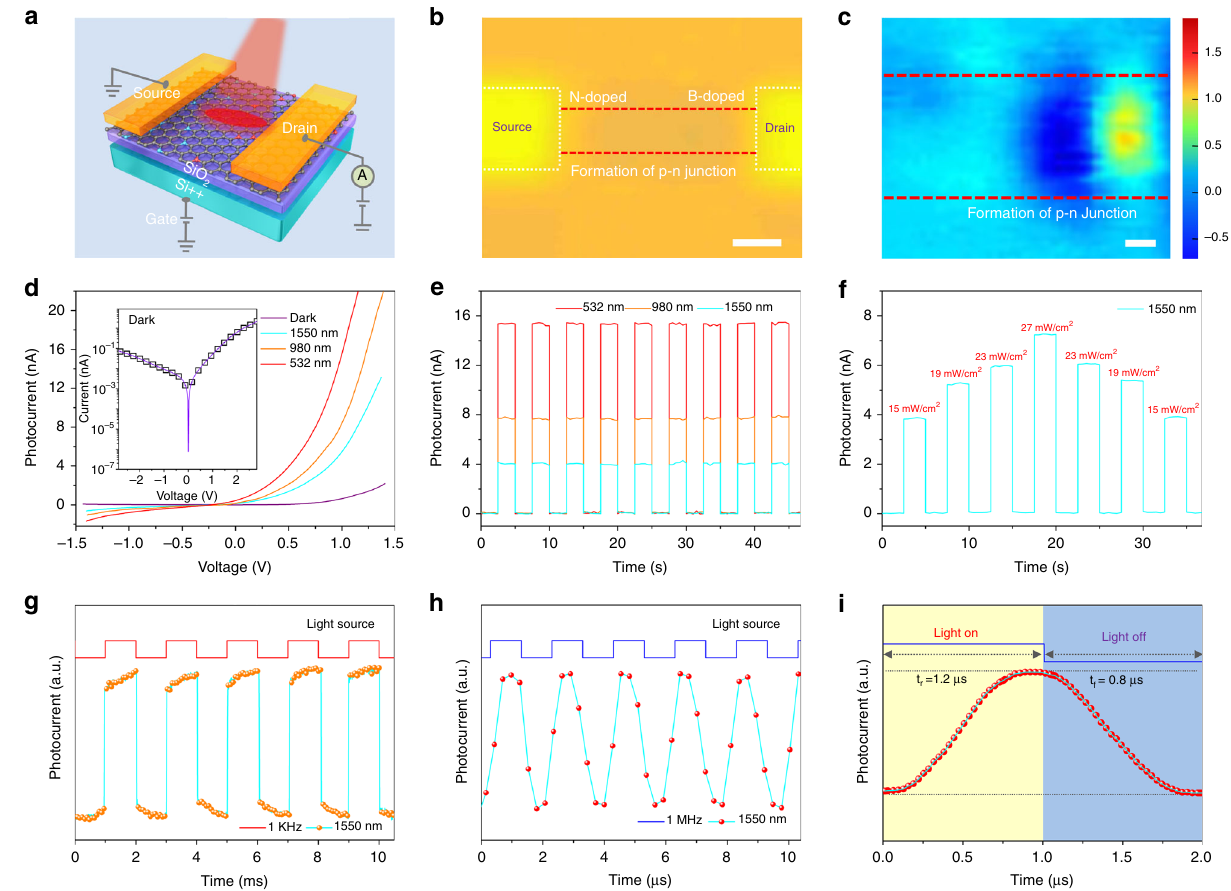
Fig. 4 Photoelectric properties of the seamless lateral graphene p – n junction. a Schematic illustration of the photodetector. b Optical micrograph of the scanned area for the photocurrent mapping measurement with the dotted lines showing the contour of the photodetector. The scale bar is 2 μ m. c Photocurrent mapping across the entire B-doped/N-doped seamless connected area (the fl uences of 4 × 10 16 atoms/cm 2 are used for both N-doped and B-doped portions) at the biasing condition of V ds = V g = 0 V. The photoexcitation power is 500 μ W and the wavelength is 633 nm. The laser spot size is 1 μ m with the spatial resolution of 0.5 μ m. The scale bar is 500 nm. d I − V ds ds characteristics of the photodetector measured in the dark and under light illumination with variable wavelengths of 532, 980, and 1550 nm, respectively. The intensity of the illuminated light is fi xed at 15 mW/cm 2 . The inset displays the dark current in logarithm scale. e Photo-switching behaviors of the photodetector towards the pulsed light illumination with variable wavelengths ( V ds = 1 V, V g = 0 V). The light intensity is fi xed at 15 mW/cm 2 . f Photo-response of the photodetector towards 1550 nm light illumination with variable intensity. Photo-response of the photodetector under the pulsed 1550 nm light illumination with frequencies of g , 1 kHz, and h , 1 MHz. i Enlarged photo-response curve at 1 MHz showing the rise time ( t r ) and fall time ( t f